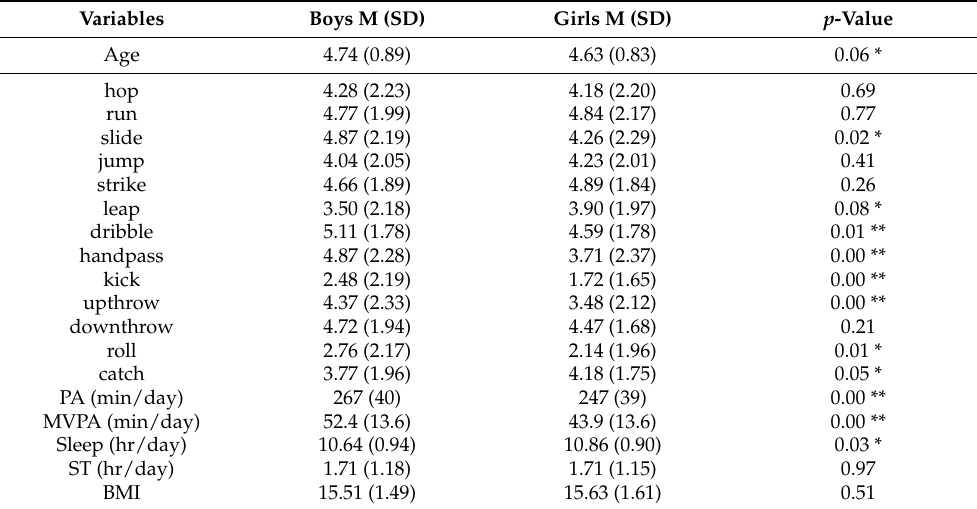
Table 2. Sample Characteristics and Differences by Gender.